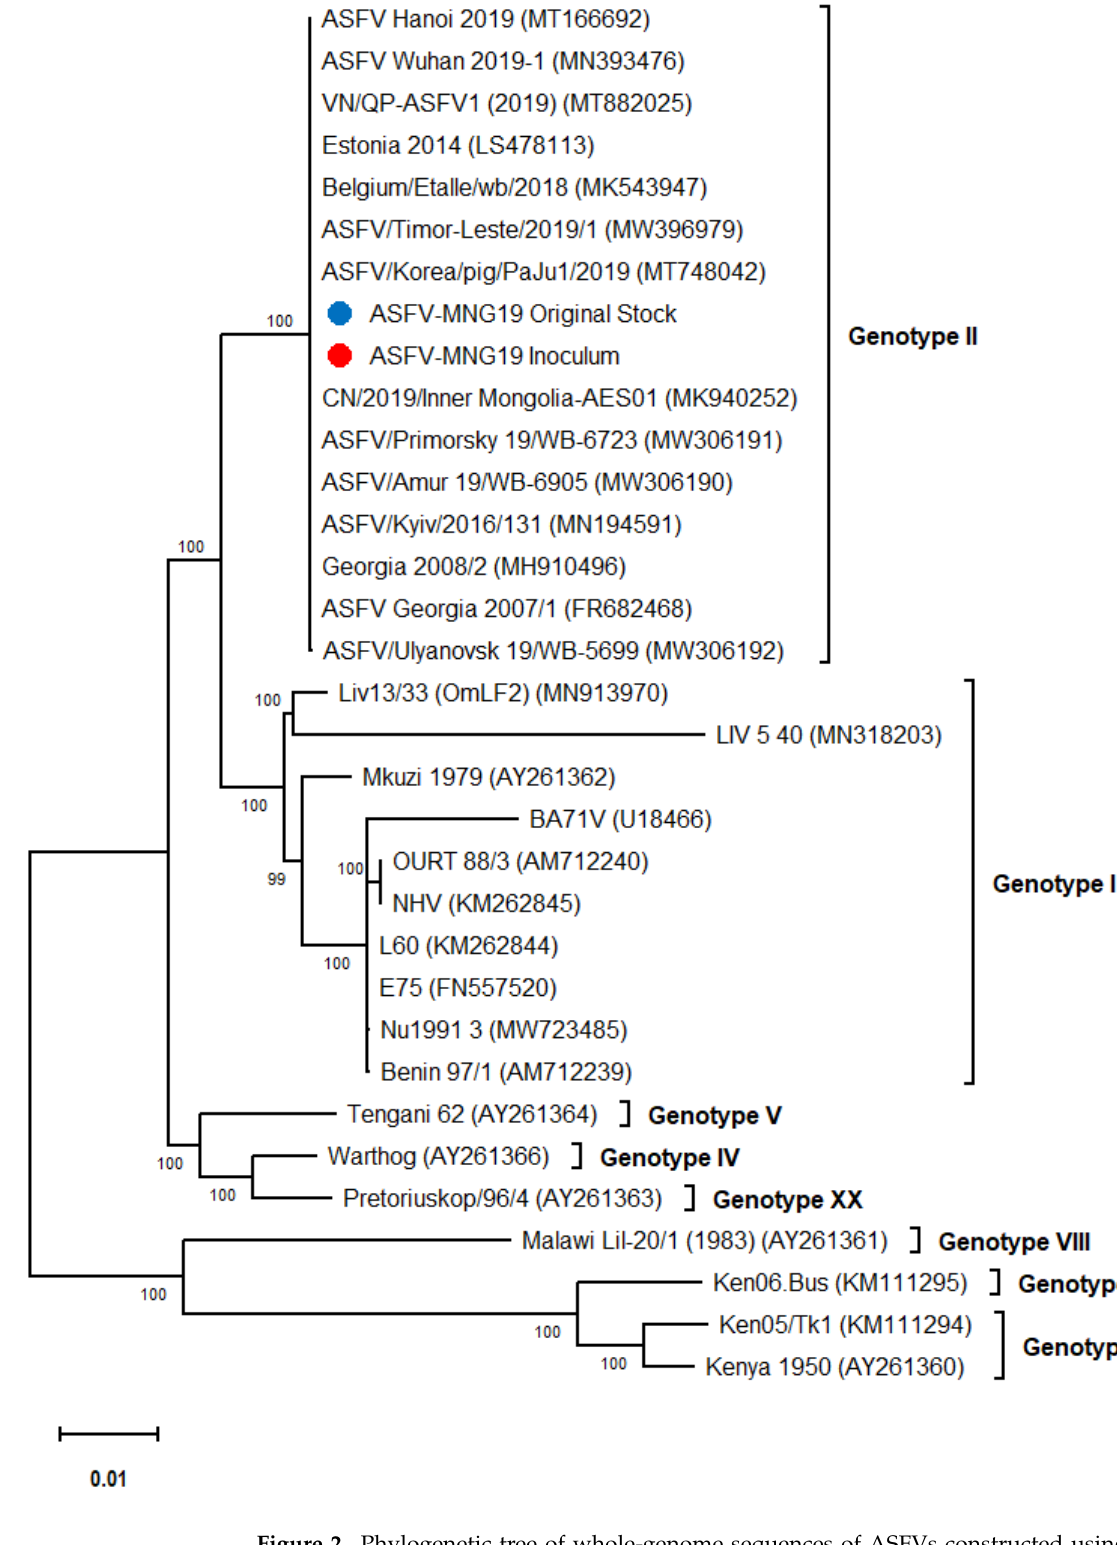
Figure 2. Phylogenetic tree of whole-genome sequences of ASFVs constructed using maximum likelihood approach with 1000 bootstrap replicates. The blue and red dots indicate the ASFV-MNG19 original stock and inoculum used in this challenge study, respectively.